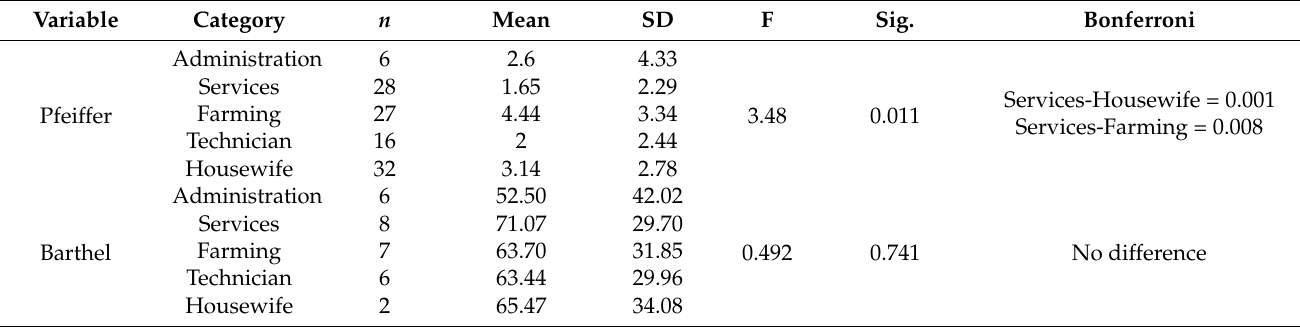
Table 3. Analysis of variance (ANOVA) results for the scales of dependency and memory and orientation in relation to the variable work. n = 109.